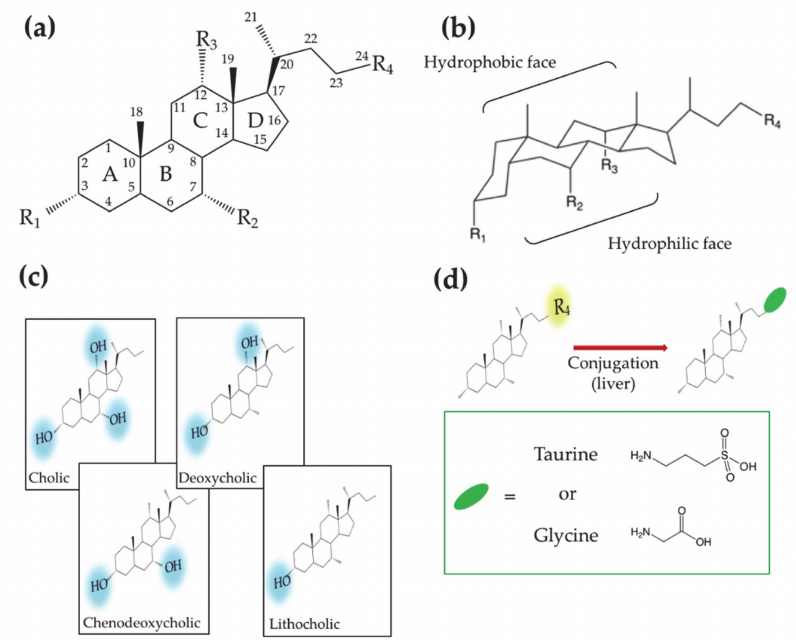
Figure 1. ( a ) Planar representation of the general molecular structure of bile acids (Bas). Letters, numbers and labels R i indicate the rings of the steroid skeleton, the carbon atoms and the functional groups, respectively. ( b ) Chair representation of the general molecular structure of BAs. Brackets indicate the hydrophobic and hydrophilic faces. ( c ) Molecular structures of BAs showing different hydroxyl groups on the steroid backbone. ( d ) Molecular structures of the aminoacid conjugated